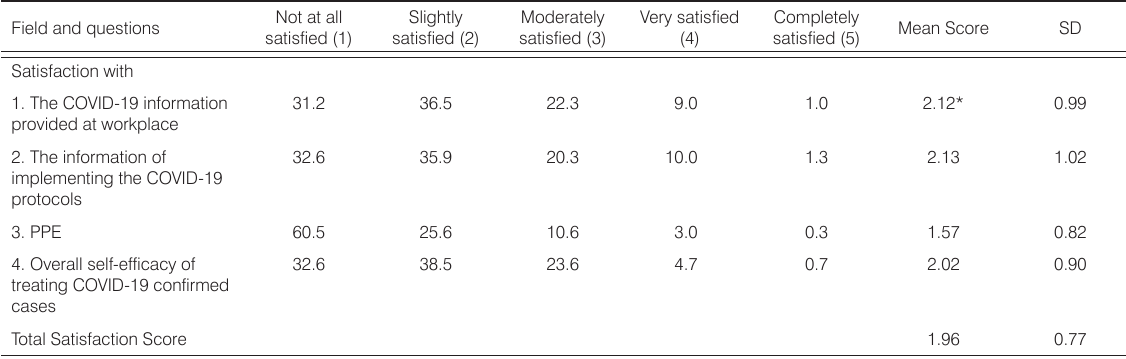
Table 2. Satisfaction regarding information, PPE, and safety during COVID-19 pandemic.